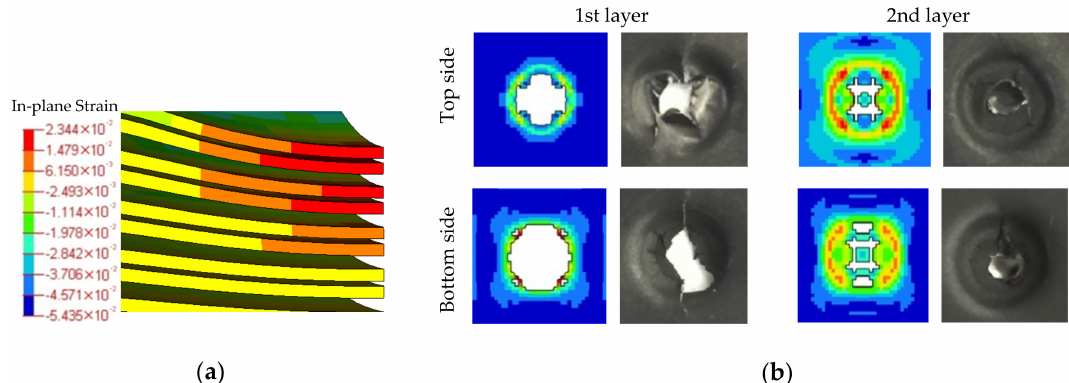
Figure 16. Simulation analysis of cathode: ( a ) The numerically prediction in-plane strain contour of the cathode coatings show that the cathode coatings on the lower side of the cathode current collector produces higher in-plane tensile strains than the layer immediately above the cathode current collector; ( b ) Comparison between experimental tests and simulation of fracture modes of cathodes across different layers under local